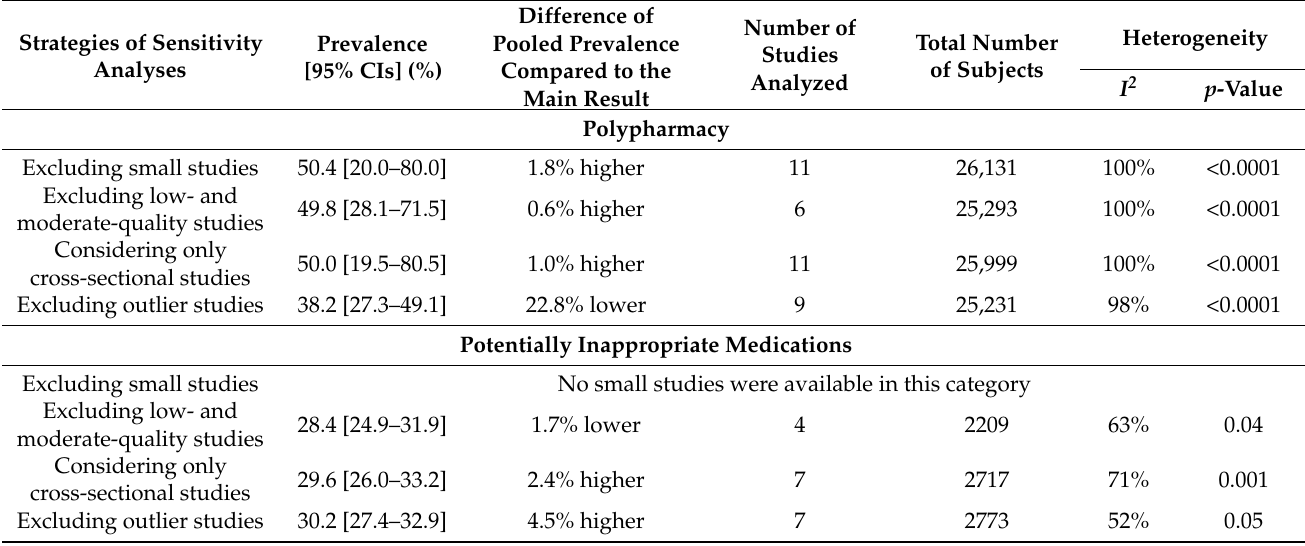
Table 3. Sensitivity